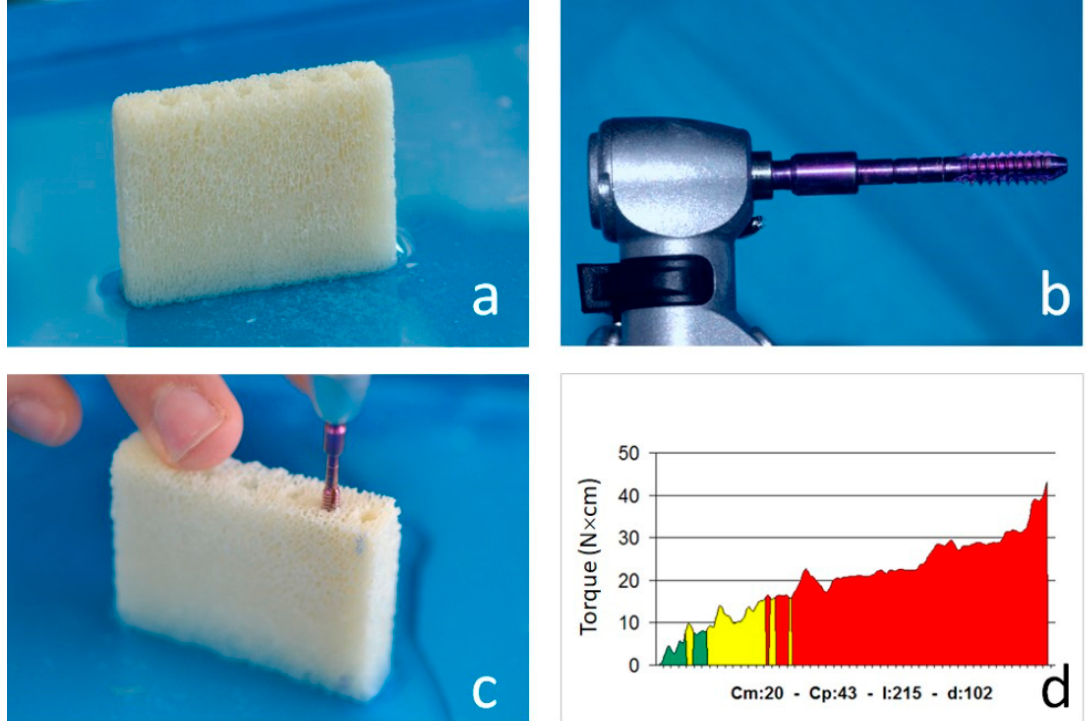
Figure 1. ( a ) One of the bone blocks used in the present study. ( b ) The bone density measuring probe. The probe is a 2-mm-wide cylinder featuring equally spaced threads whose width is mm and shape is a 1-degree reverse cone. When the probe screws into the hole ( c ), only the first thread exerts friction on the bone walls, because of the reverse cone shape. The micromotor display shows an instantaneous torque–depth curve ( d ), also indicating the average torque (Cm, N × cm), the peak torque (Cp, N × cm), the integral of the curve (I, N × cm 2 /100) and the depth (d) reached by the probe in tenths of